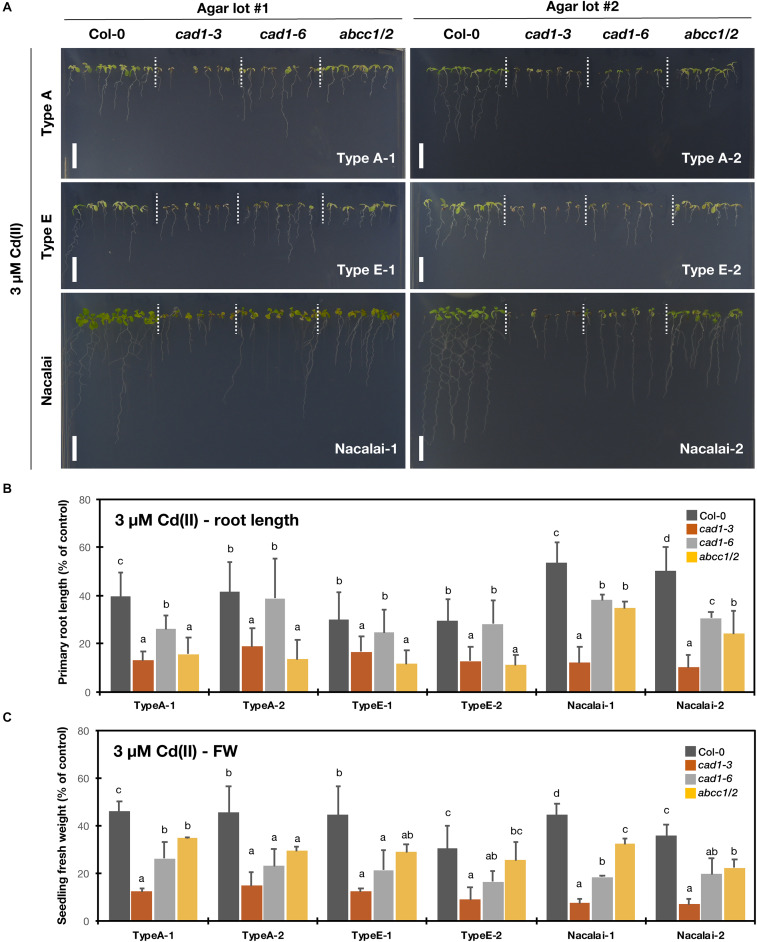
Cd(II)-sensitivity of the phytochelatin-related Arabidopsis mutants on the agar plates prepared with different agar reagents. Three types of agar reagents with two independent lots for each type were tested. Col-0, cad1-3, cad1-6, and abcc1/2 were grown on the agar medium containing 3 μM Cd(II) for 12 days. (A) Phenotypes of Col-0, cad1-3, cad1-6, and abcc1/2. Scale bars = 1 cm. (B,C) Relative primary root length (B) and fresh weight of seedlings (C) of Col-0, cad1-3, cad1-6, and abcc1/2. Values are shown as percentage of each control. Data represent means with SD from at least three independent experiments (n = 24–28 for root length, and n = 3–4 for seedling fresh weight). Means sharing the same letter are not significantly different within each agar reagent (P < 0.05, Tukey’s HSD).